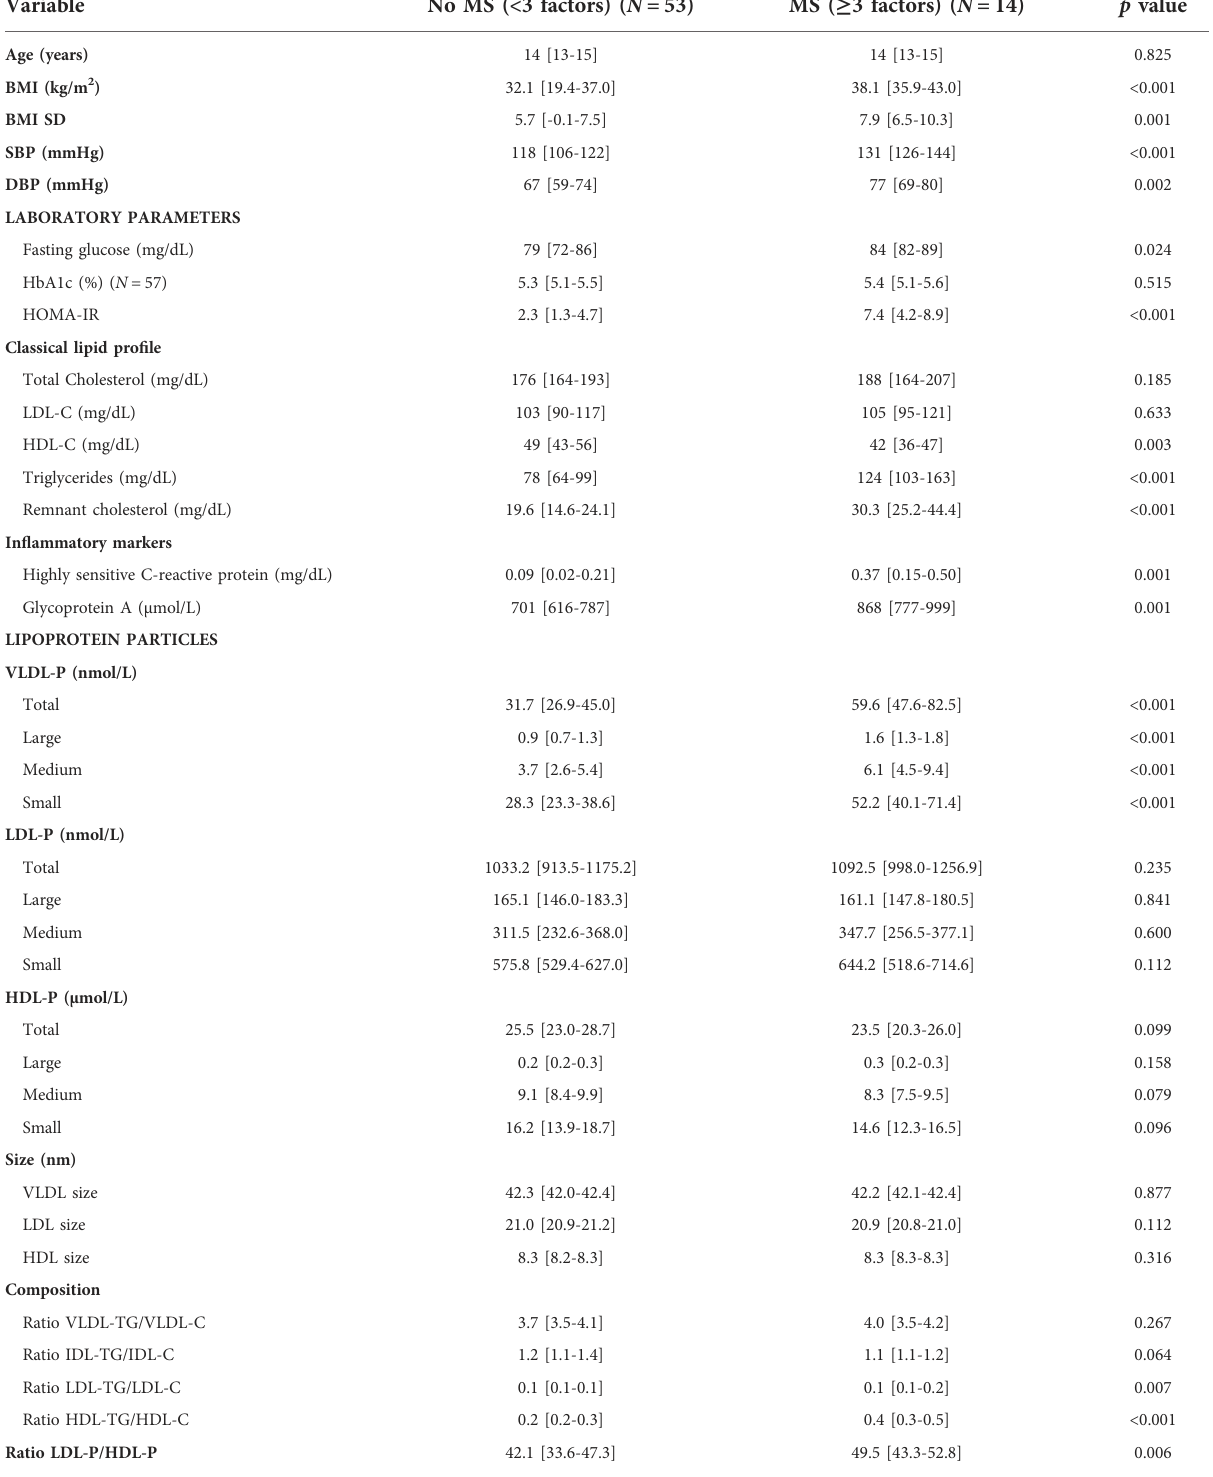
TABLE 3 Clinical and laboratory characteristics of subjects depending on metabolic syndrome (MS)